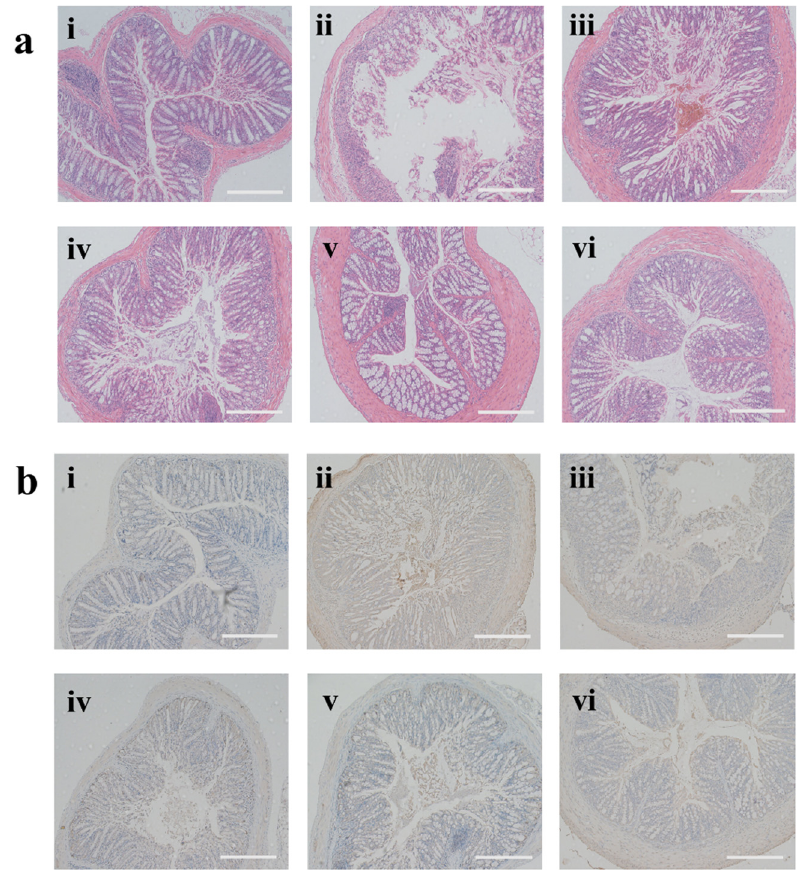
Figure 7. ( a ) H & E-stained colon tissues and ( b ) the expression profiles of ZO-1 in different mouse groups. (i) healthy control, (ii) DSS control, (iii) SF-NPs-treated DSS group, (iv) RSV-NPs-treated DSS group, (v) PF-127-NPs-treated DSS group (1%), and (vi) PF-127-NPs-treated DSS group (5%). Scale bar represents 200 μ m.